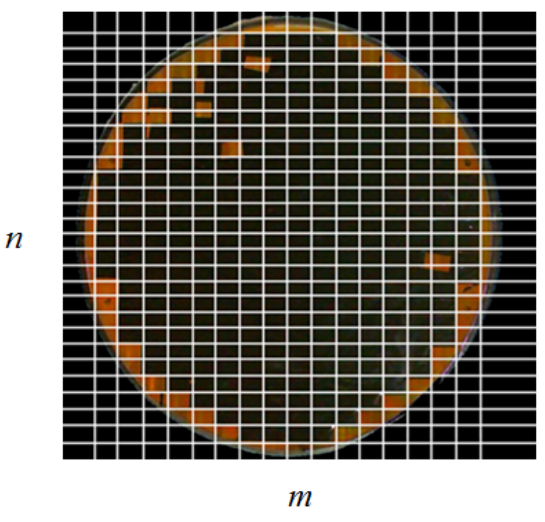
Figure 17. Wafer image mapped in the matrix defined by using the detected die sawing lines.